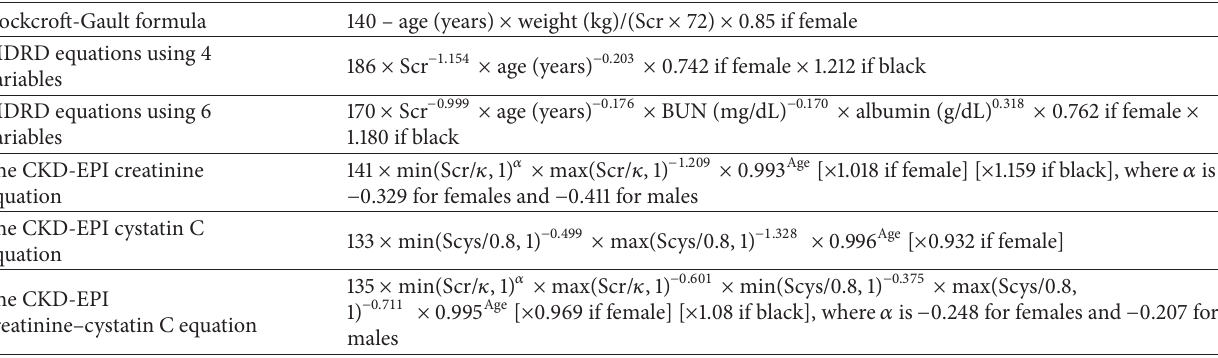
Table 1: GFR-estimating equations used in the